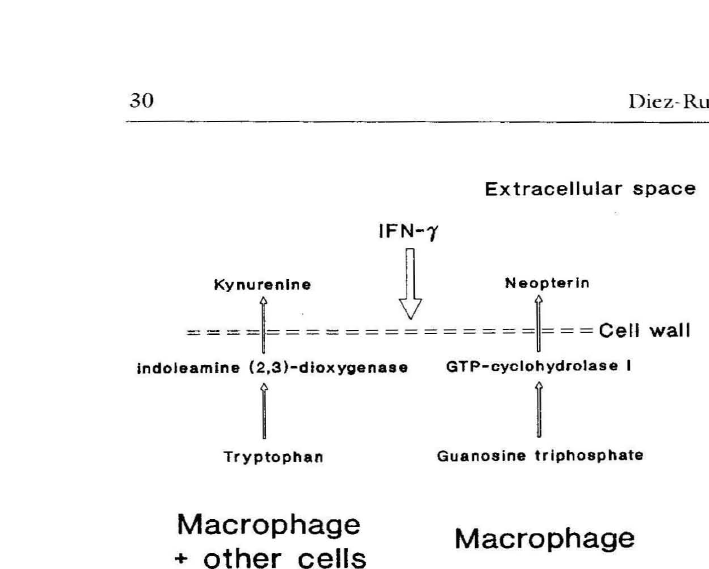
Figure 1. Scheme of the association between neopterin production and tryptophan degration induced by in terferon-y. The cytokine induces GTP-cyclohydrolase I and consequently neopterin production in human monocytes/ macrophages; in parallel indoleamine (2, 3) dioxygenase is activated which degrades tryptophan via the N-formyl-kynurenine pathway to produce kynuren ine as a major